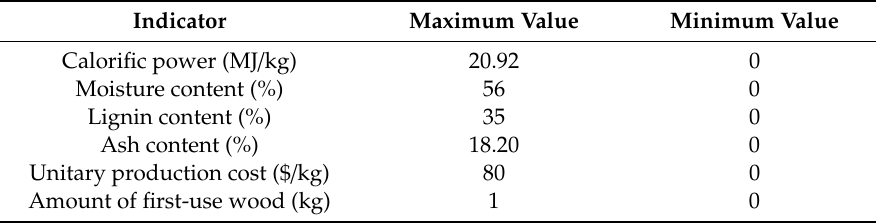
Table 8. Values of the indicators.